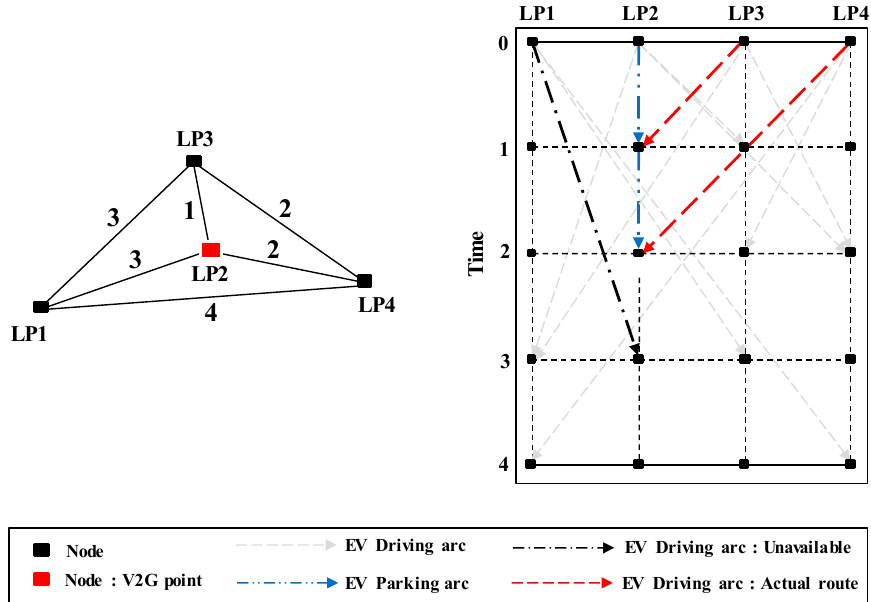
Figure 2. Example of time–space network modeling.